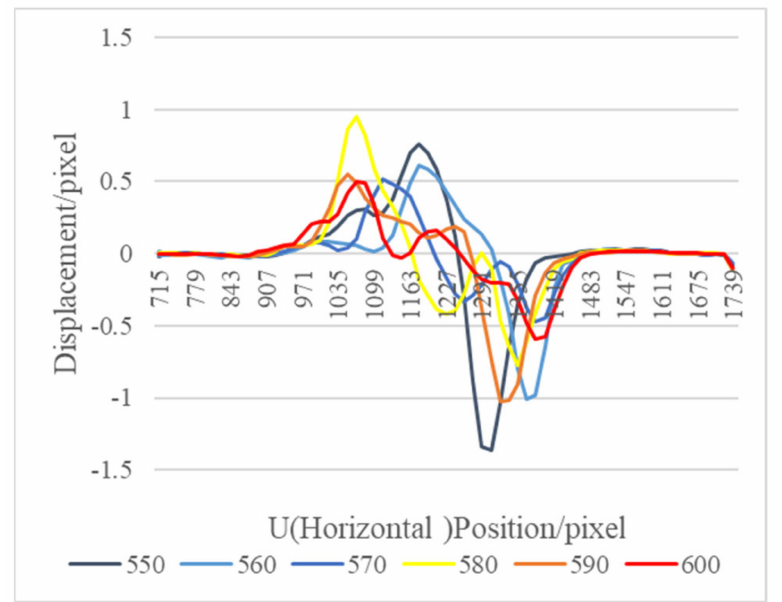
Figure 12. Frame skipping baseline analysis